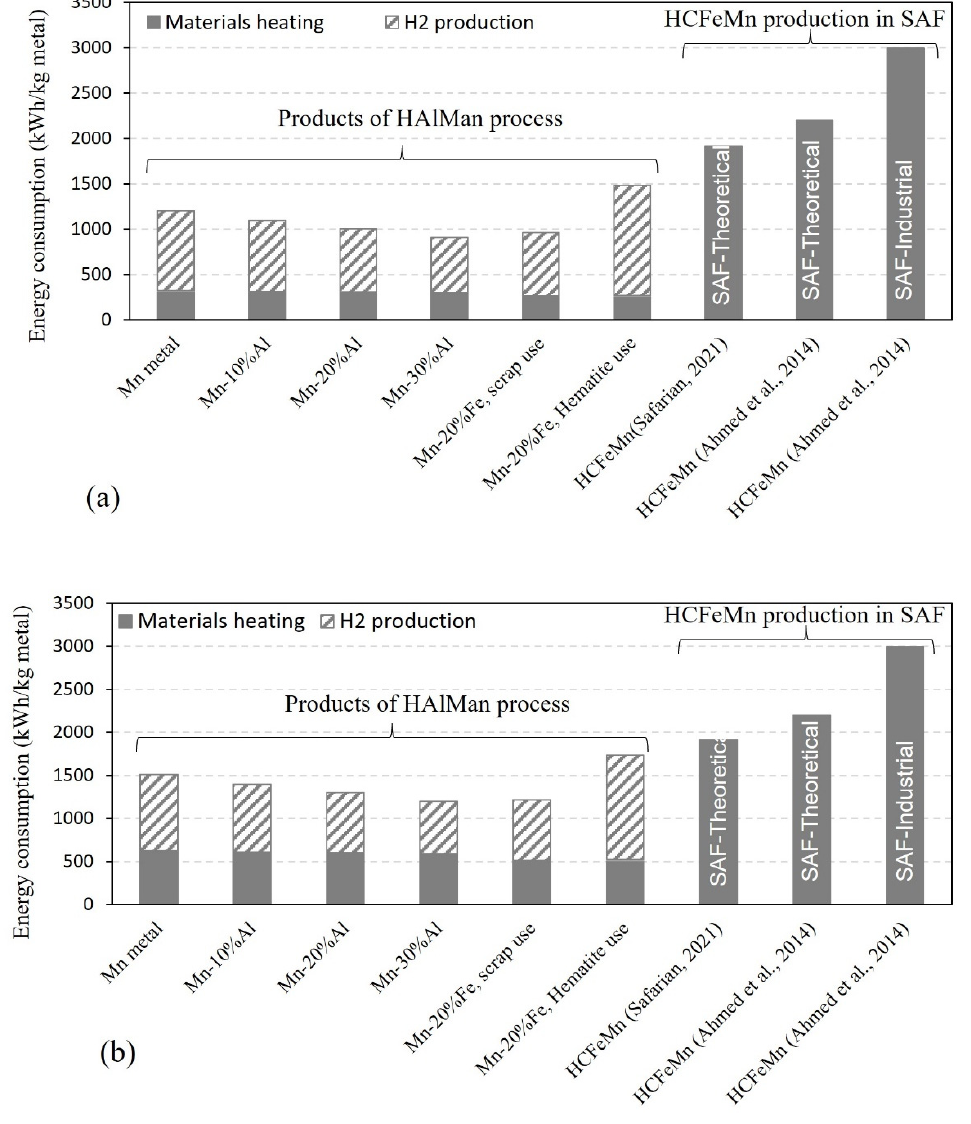
Figure 13. Energy consumption to produce metals by HAlMan process for the case of 50% ( a ) and 100% ( b ) loss of the released heat from the aluminothermic reduction, and comparison with SAF for HCFeMn production.